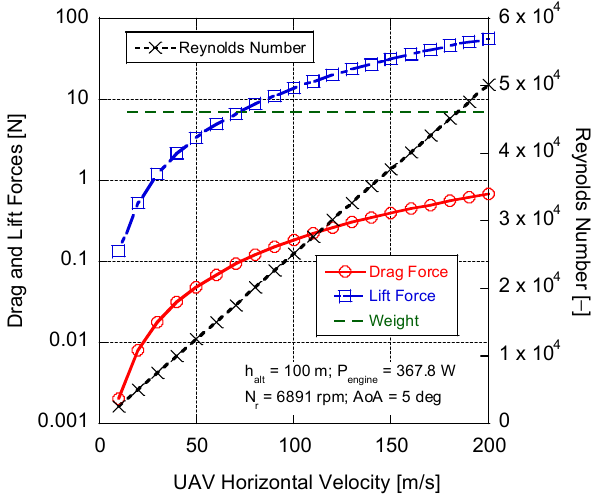
Figure 11. Drag force, lift force, and Reynolds number at an AoA of 5 degrees.